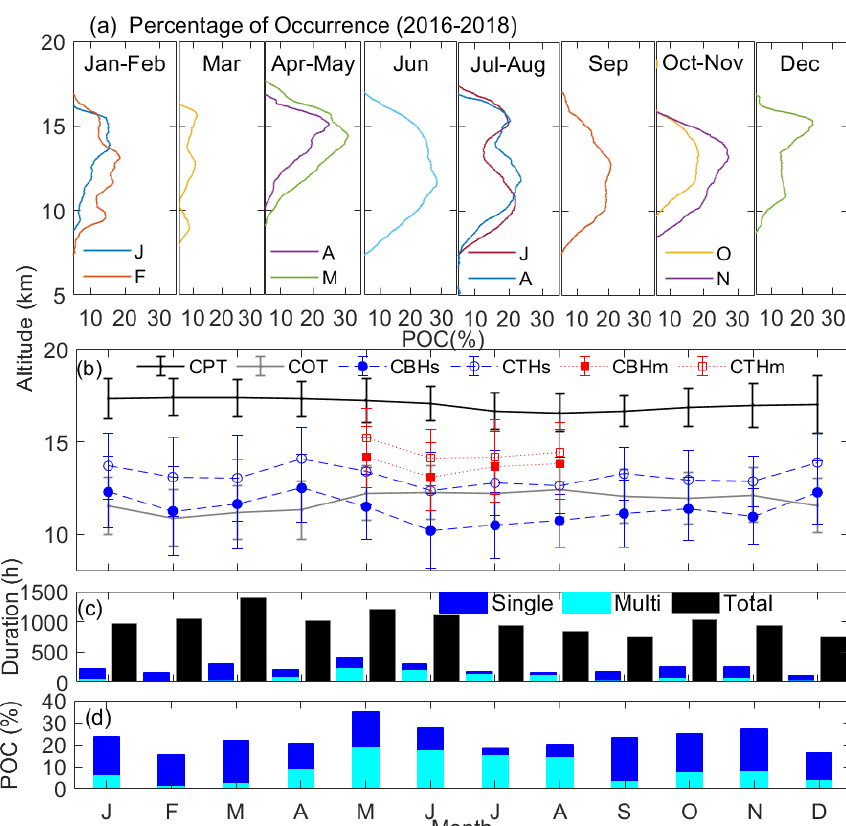
Figure 7. (a) Monthly variation in the altitudinal extent of the POC; (b) monthly mean and standard deviations of the altitudes of the cloud base (CBH), cloud top (CTH), CPT, and COT; (c) monthly total observations of MPL; and (d) the occurrence of the single- and multilayer cirrus clouds over the period from 2016 to 2018. The suffixes “s” and “m” in relation to CBH and CTH denote “single” and “multi”,